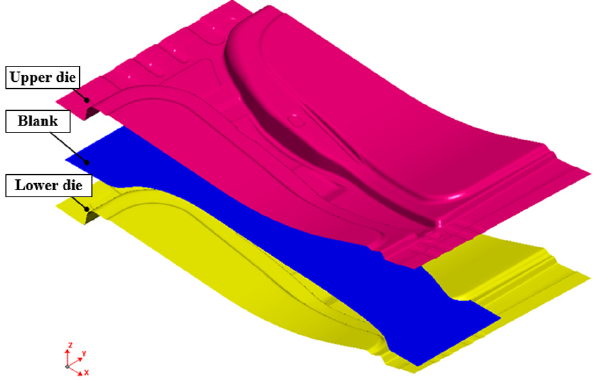
Figure 3. FE model for the hot stamping of the B-pillar.